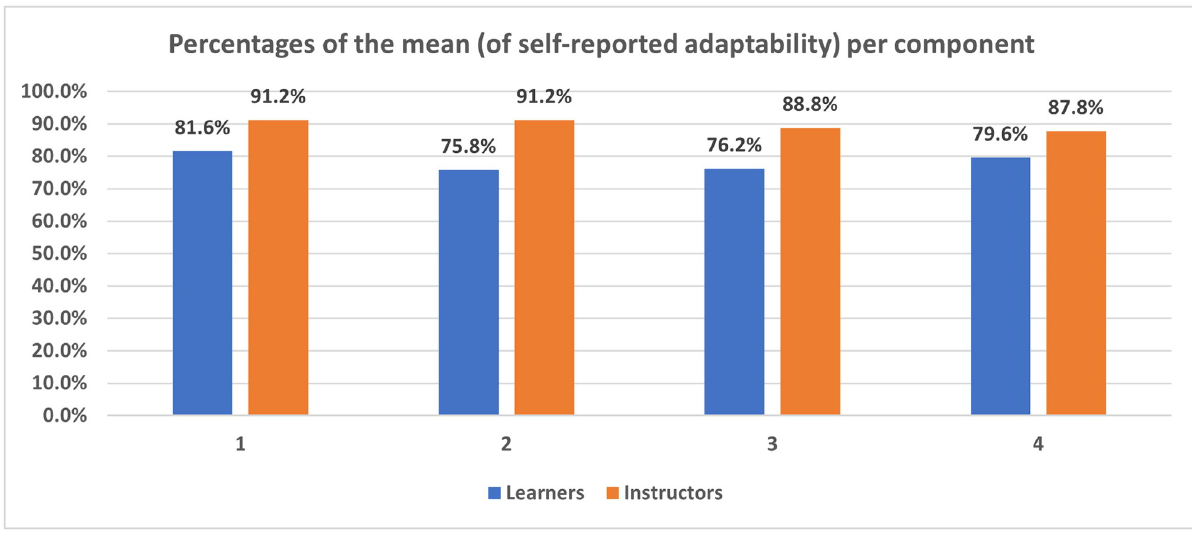
Fig 1. Comparison between percentages of the mean per component (1 through 4) between learners and instructors.